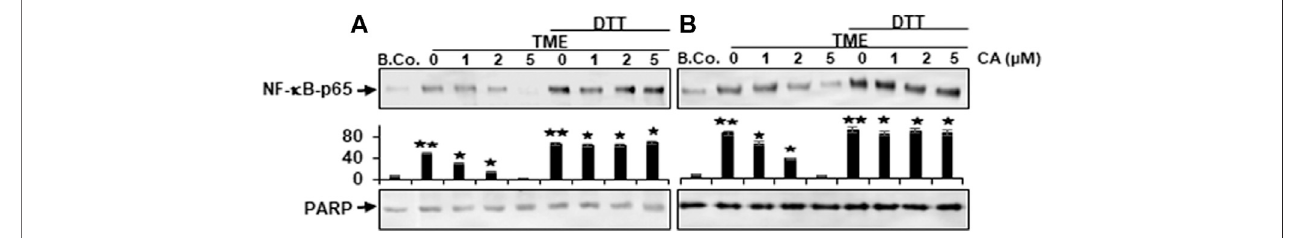
FIGURE 7 | Calebin A acts on TME-induced p-NF- κ B-p65 engagement with DNA in colorectal cancer cells. (A) HCT116 and (B) RKO cells in alginate beads were cultured alone (B. Co.) or in TME were cultured alone or subjected to Calebin A (CA) as outlined in the Materials and Methods. Dissected nuclei of basal control or TME cells that has been allowed toincubate for 30 min with the stated concentrations ofCalebinA in thepresence or absence of5 mM DTT were processed, then examined for p-NF- κ B-p65 linkage to DNA using Western blotting. PARP acted as control. Densitometric assessment was done for the indicated proteins. * p < 0.05, ** p < 0.01 relatively to basal